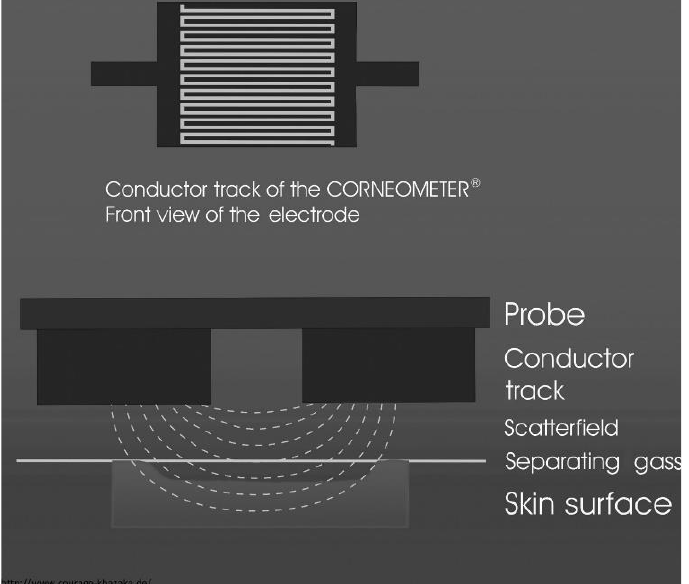
Figure 5. Measurement principle of the Corneometer ® CM 825. On the top is the front view of the electrode, revealing its interdigitated shape and on the bottom is the side view, illustrating the scattered electric field. Image reproduced with permission from [64].